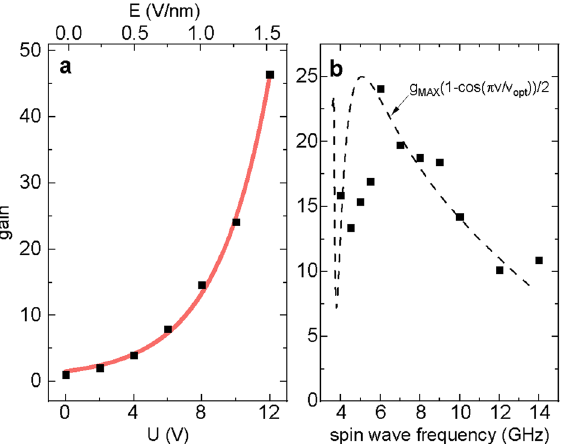
Figure 6. ( a ) The dependence of the maximum gain of the spin-wave amplitude on the amplitude of the ac voltage in MEC; ( b ) the dependence of the gain on the spin-wave frequency passing MEC. Black points are the results of simulations, while the black dashed curve in ( b ) is obtained from the group velocity